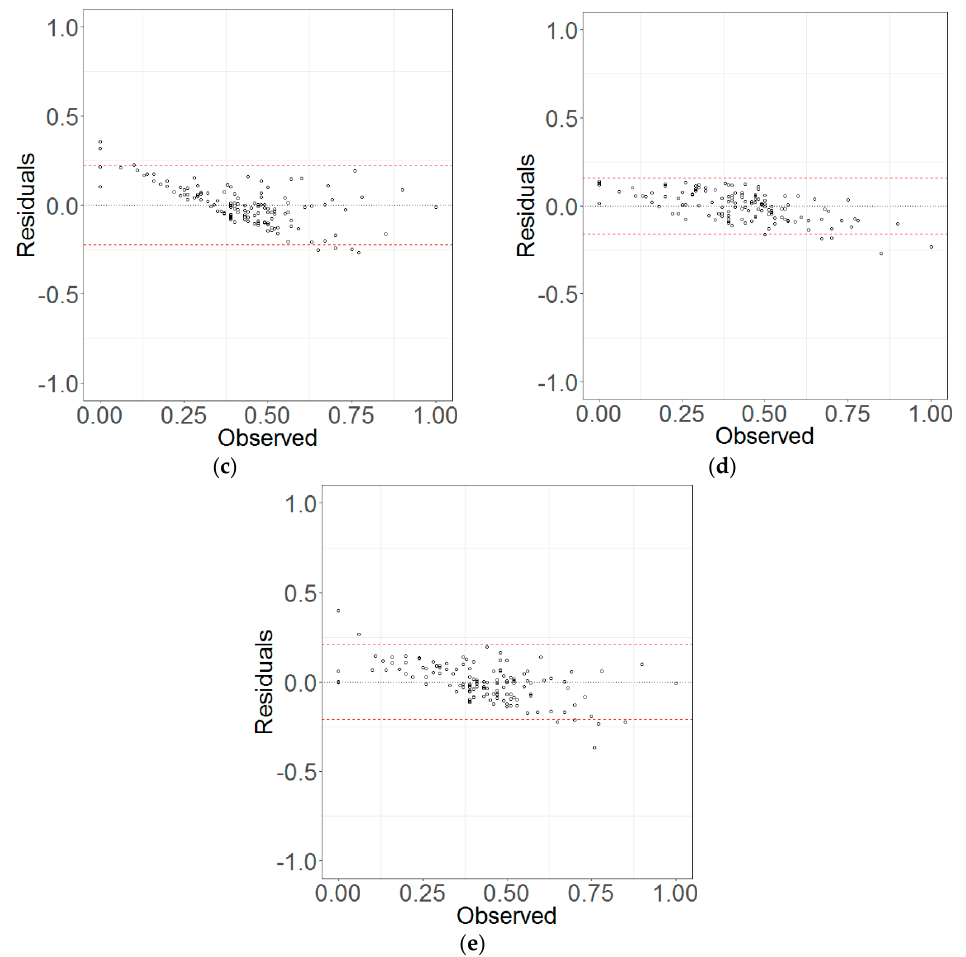
Figure 13. The residuals of percentage vegetation cover predictions graphed against the observations or referenced values for Kangbao County using: ( a ) Linear stepwise regression (LSR); ( b ) Geographically weighted regression (GWR); ( c ) Constant kNN (Cons_kNN) with 3 nearest plots; ( d ) Optimized kNN (Opt_kNN); and ( e ) Random forest (RF). The red dashed lines represented the confidence interval of zone residuals at the significant level of 0.05.